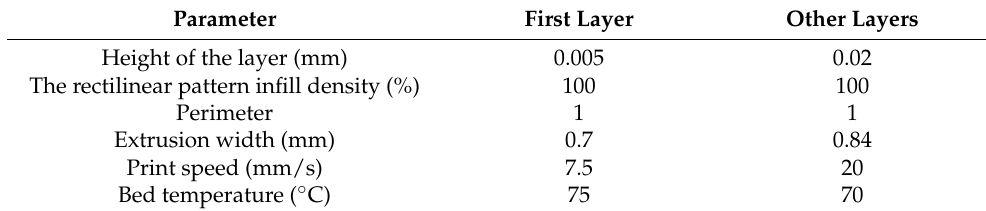
Table 1. Printing parameters.